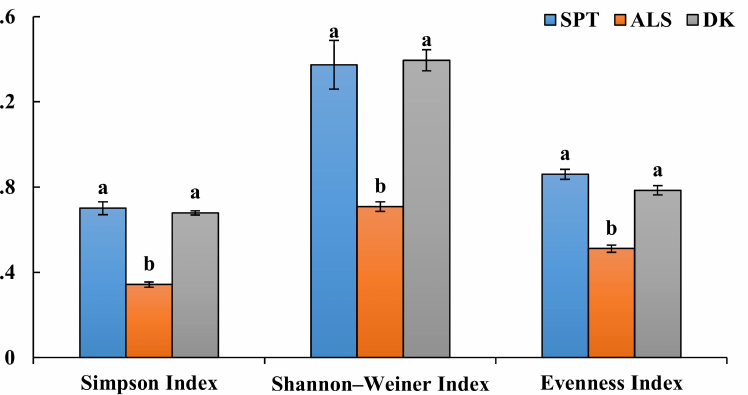
Figure 5. Assessment of the species diversity indices and colonization rate of DSE fungi at three sample sites. Note: SPT, Shapotou. ALS, Alxa. DK, Dengkou. Different letters above the error bars indicate a significant difference at p < 0.05.